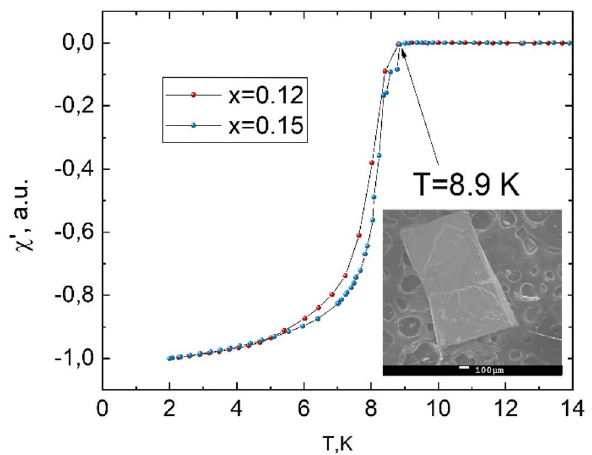
Fig. 1 AC susceptibility temperature dependences of SrFe single crystals with H = 5 Oe. Inset: The photo of the as-grown ac SrFe Ni As single crystal 1.85 0.15 2